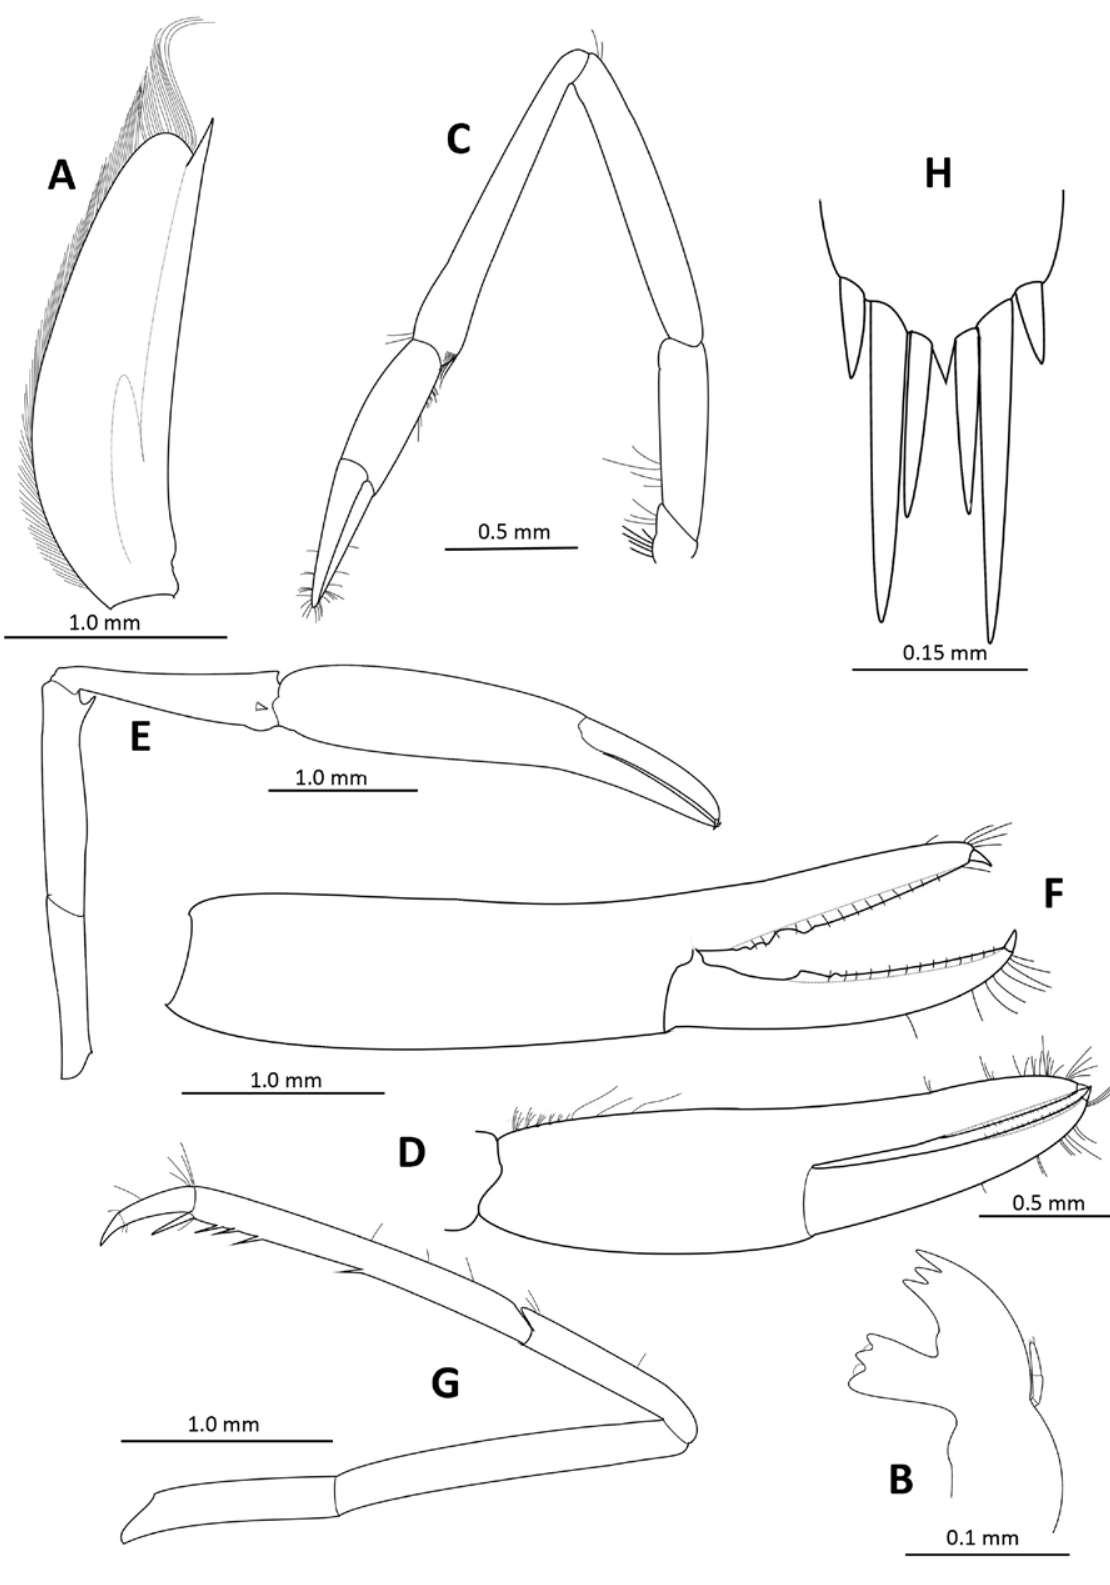
Figure 2. Palaemonella tenuipes Dana, 1852 (female, CL 2.5 mm) from Lakshadweep Islands, India. A , dorsal view of antennal scaphocerite; B , lateral view of the mandible, closer; C , lateral view of the first pereiopod; D , dorsal view of first pereiopod chela, closer; E , lateral view of the second pereiopod; F , dorsal view of second pereiopod chela, closer; G , lateral view of the third pereiopod; H , dorsal view of the posterior part of